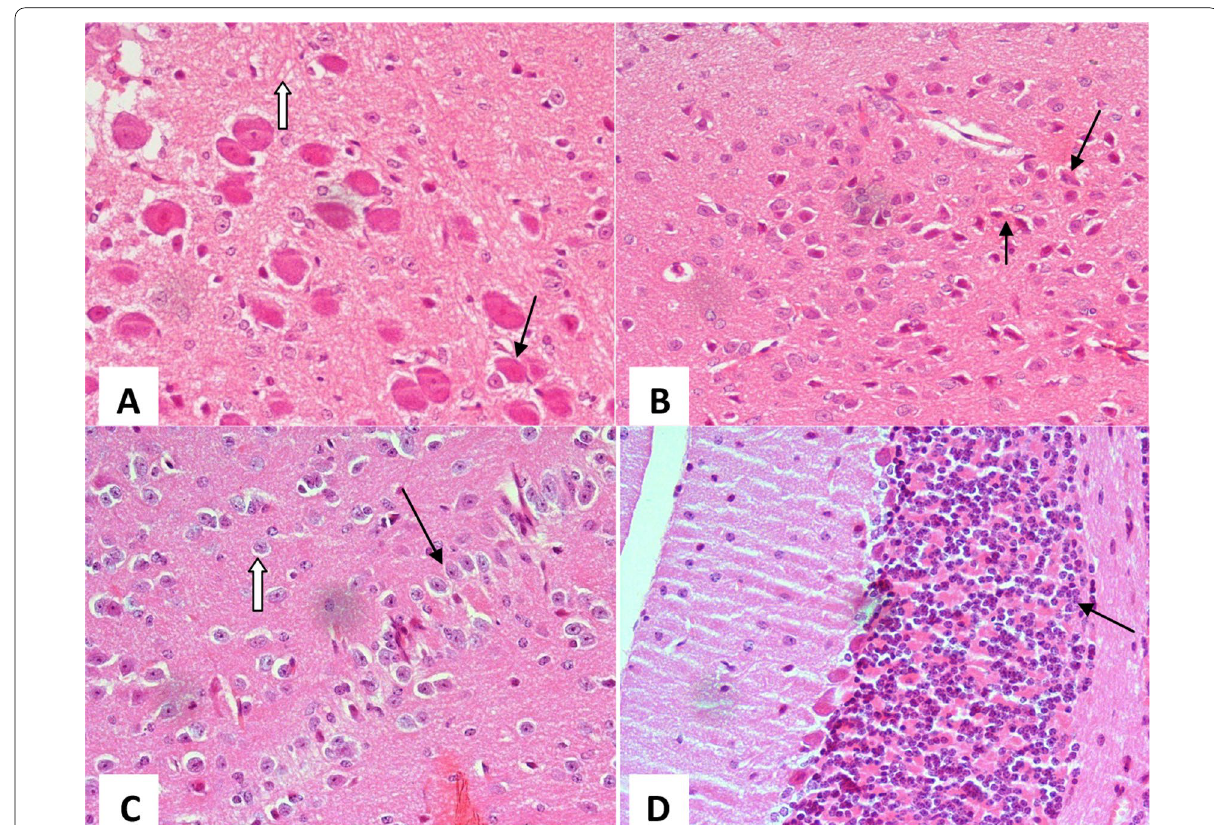
Fig. 10 A Brain tissue of mice treated with (R COF PQ) showing prominent cellularity with numerous pyramidal pigmented neuronal cells + + (black arrow); however, still, residual vacuolar degeneration was observed in the background (white arrow). B Brain tissue of mice treated with (R COF PQ) showing restored cellularity; however, pigmented pyramidal neuronal cells still showed some changes with irregular contour (black + + arrows). C Brain tissue of mice treated with (R